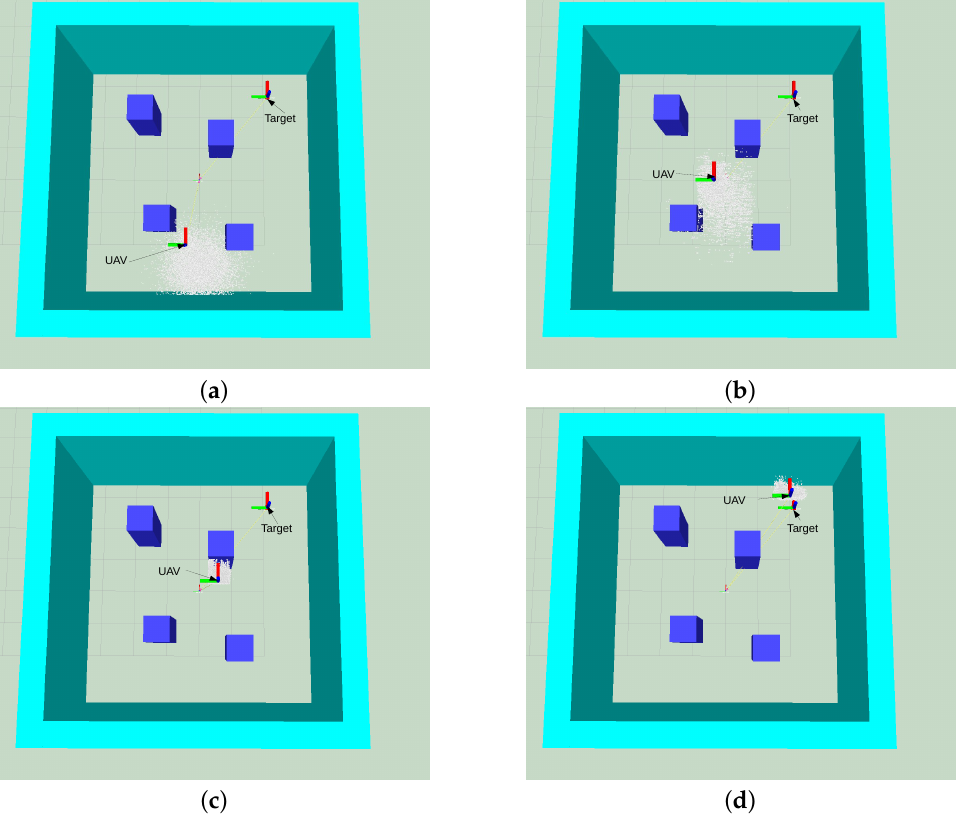
Figure 5. Belief evolution for the navigation problem using the POMCP solver. Target’s position (red); UAV position (white). ( a ) Initial belief, UAV location (white particles) and target location (red particles); ( b ) belief after some steps; ( c ) UAV in front of obstacle; uncertainty is reduced; ( d ) target within UAV downward camera